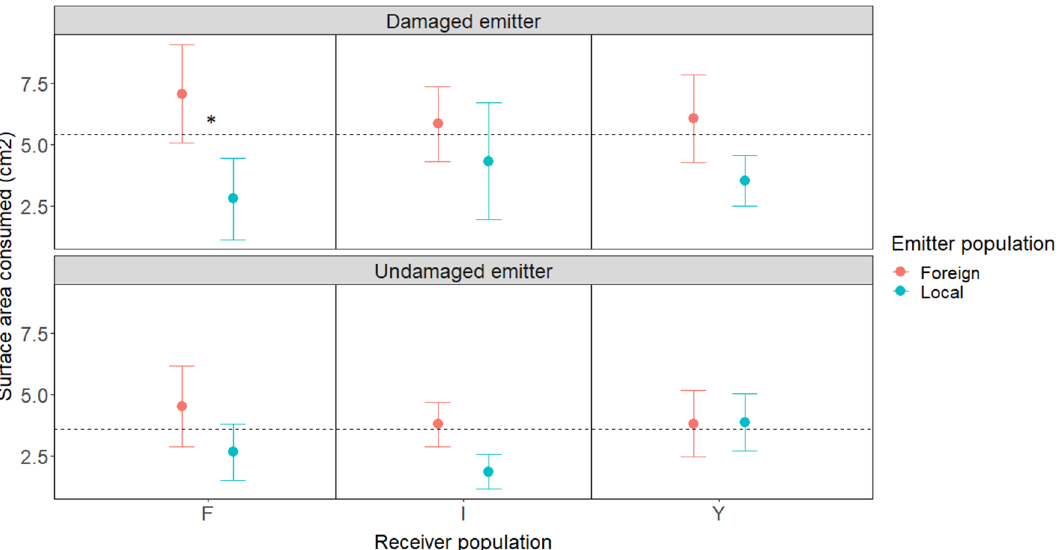
Figure 1. Means ± SEs from volatile exposure and herbivory experiment. F, I, and Y represent the Flores, Inka, and Yel populations, respectively. Dotted lines represent mean damage across all receiver populations for the damaged and undamaged emitter treatments. Asterisks represent significant differences ( p < 0.05). Table 1. Results from a GLMM of an herbivory assay with D. balteata and P. lunatus plants from three populations exposed to damaged (Dam.) or undamaged (Und.) emitter plants (treatment) from local (Loc.) or foreign (For.) populations. Factor X 2 DF p Receiver pop. 0.248 0.883 Emitter (Loc. vs. For.)